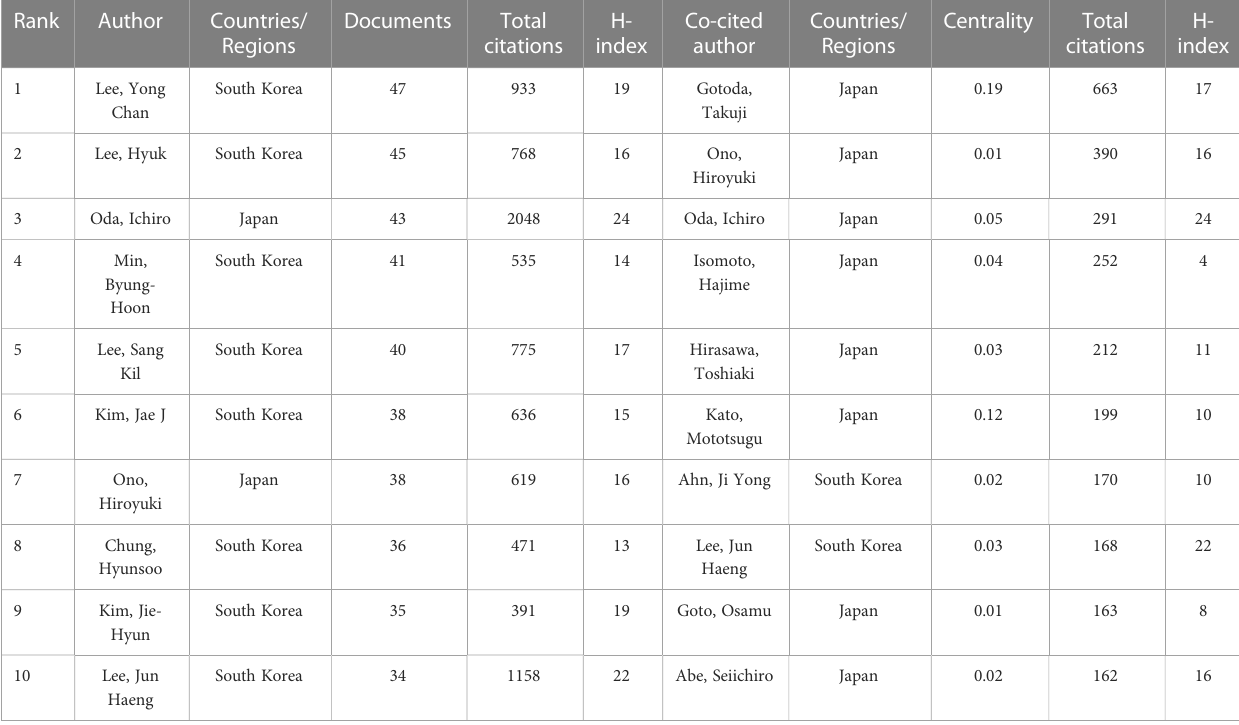
TABLE 4 Top 10 most productive authors and top 10 co-cited authors with the highest